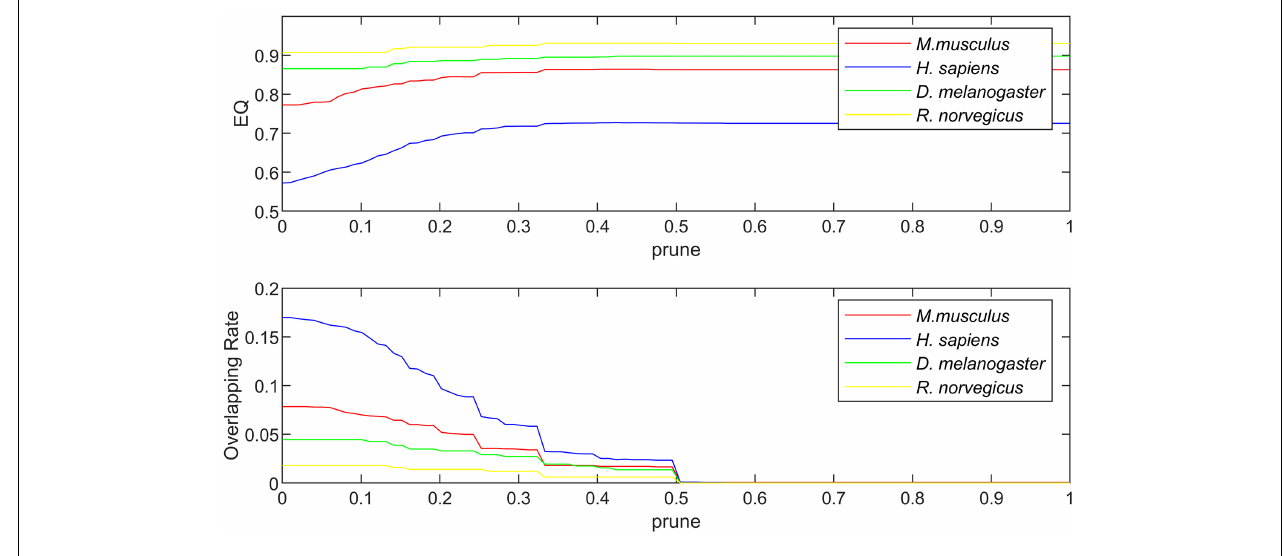
FIGURE 5 | The relationship between EQ, OR and prune in the PPI networks.